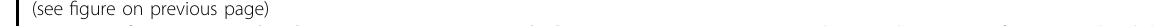
Fig. 4 TGF- β 1 is associated with a GF-to-CAF transition, which increases GIST migration. a Photographic images of GFs treated with human recombinant TGF- β 1. Scale bars, 50 µm. GFs were treated with TGF- β 1 (10 ng/mL) for 48 h. b Effect of TGF- β 1 treatment on mRNA expression of CAF markers ( CCL2 , RAB3B , and TNC ) in GFs by qPCR. c Effect of anti-TGF- β 1 blocking antibody on the expression of FGF1 , FGF5 , and FGF9 in GFs treated with TGF- β 1. GFs were treated with TGF- β 1 (10 ng/mL) and/or anti-TGF- β 1 blocking antibody (1 µg/mL) for 48 h. The expression levels of these genes were measured by qPCR. d Experimental design for Transwell migration assay of anti-TGF- β 1 blocking antibody. After GFs were seeded on the bottom, TGF- β 1 (10 ng/mL) and anti-TGF- β 1 blocking antibody (1 µg/mL) were added for 24 h. e – g Representative images ( e ) of the migrated GIST cells stained with 0.05% crystal violet in the indicated group and quantitative data in GIST-T1 cells ( f ) and GIST882 cells ( g ) analyzed by ImageJ software. Scale bars, 200 µm. All graphs show mean ± SEM, and p values were represented by Student ’ s t test or ANOVA analysis. ** p < 0.01, *** p <